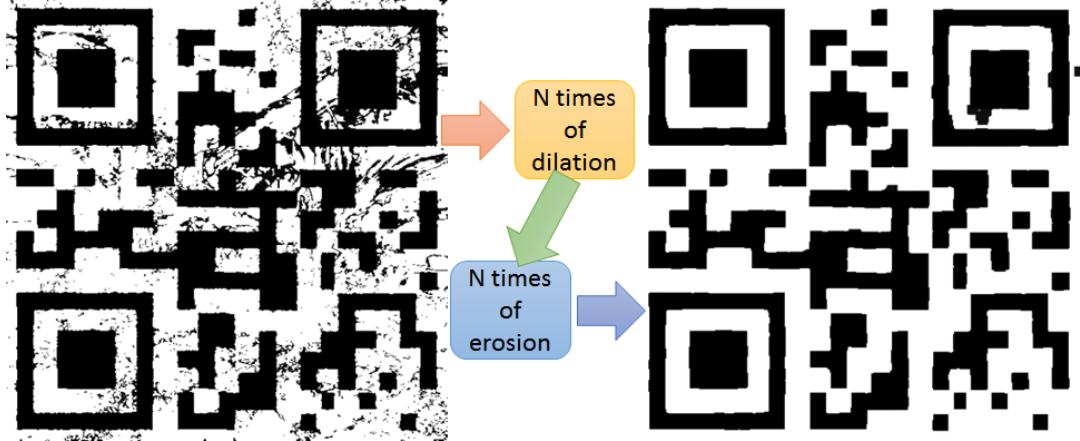
Figure 17. Dilation and erosion to clear noises in extracted QR